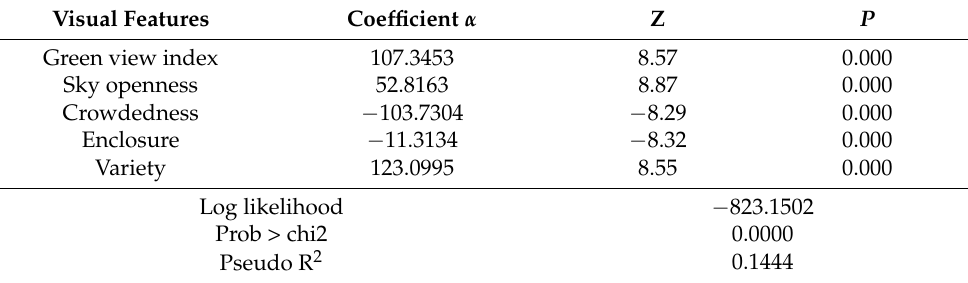
Table 4. Fitting results of the stated preference survey (N =